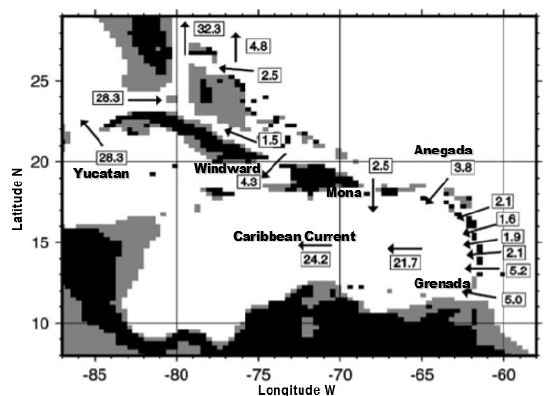
Figure A1. Passage flows (Sv) around the Caribbean adapted from [22].